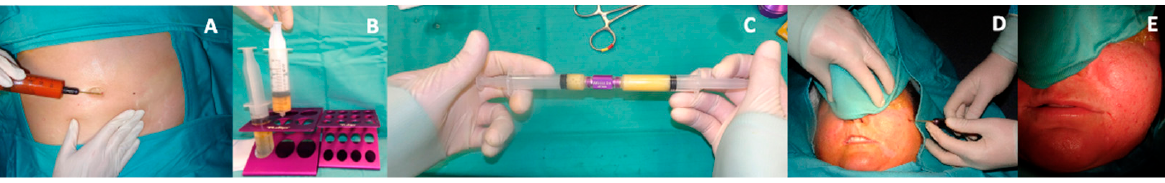
Figure 3. Fat collection from the abdominal region ( A ), fat decanting ( B ), fat processing ( C ), fat grafting ( D ), and the immediate postoperative state ( E ).